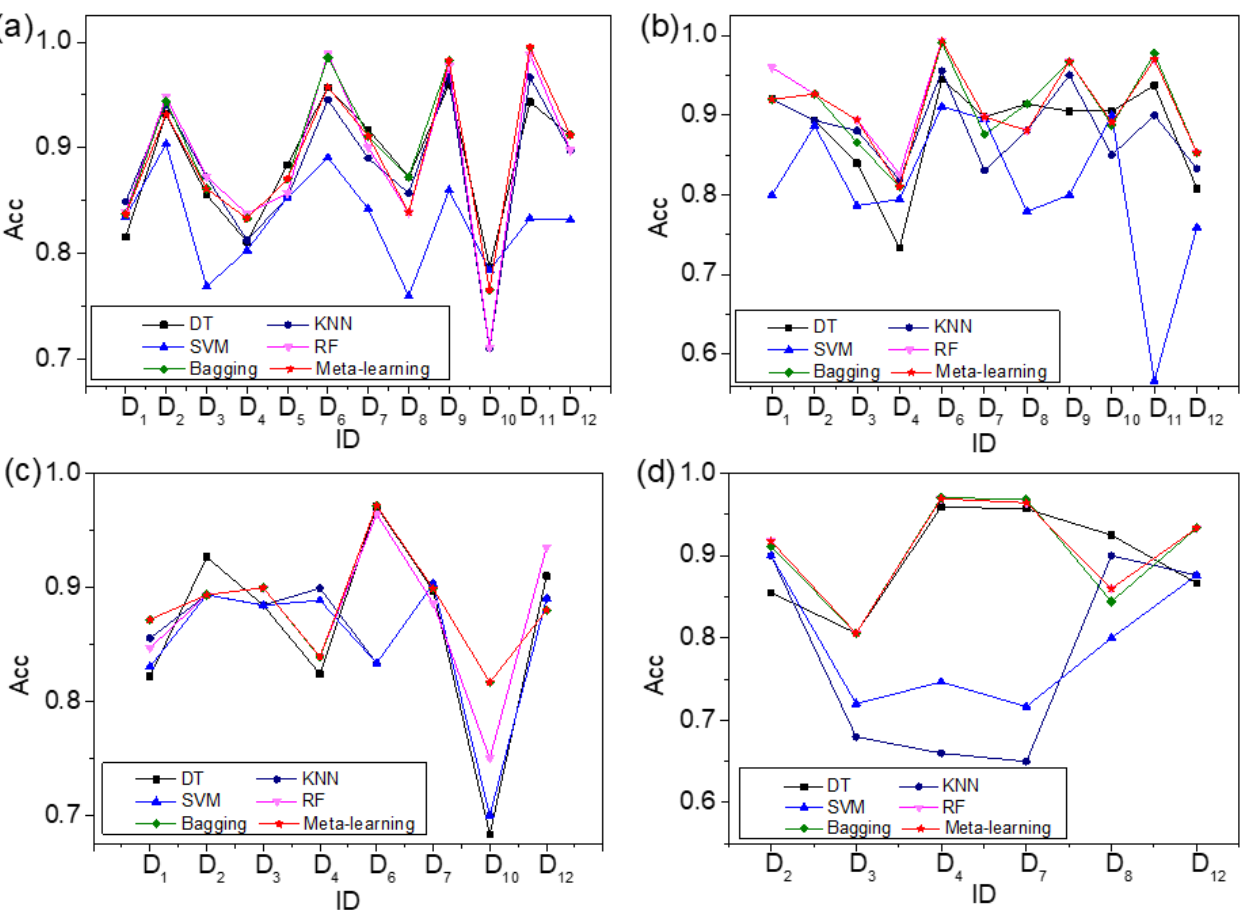
Figure 8. Accuracy comparison between meta-learning and traditional ML algorithms. ( a ) all, ( b ) quinaries, ( c ) senaries, and ( d ) septenaries.